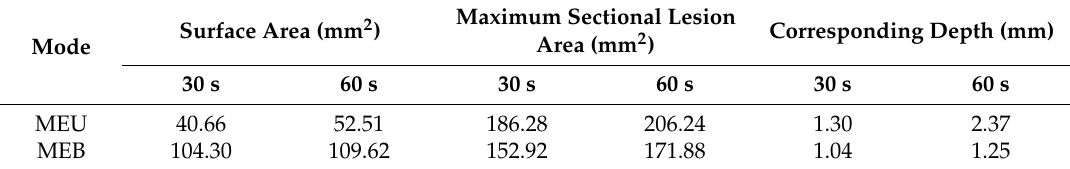
Table 3. Surface lesion area, the maximum sectional lesion area inside of the myocardium, and the corresponding depth to approach the section in the MEU and MEB modes at 30 s and 60 s of RFCA.